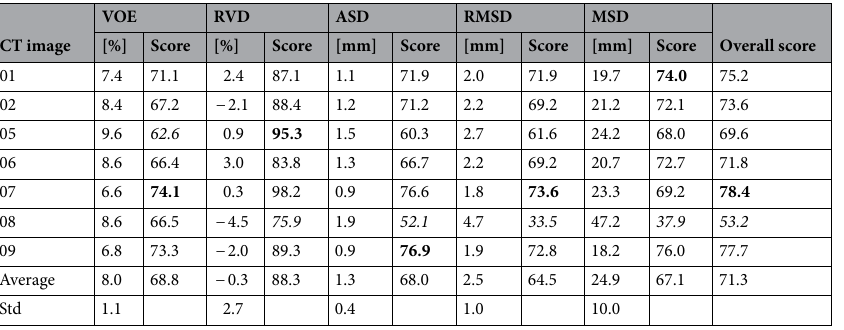
VOE RVD CT image